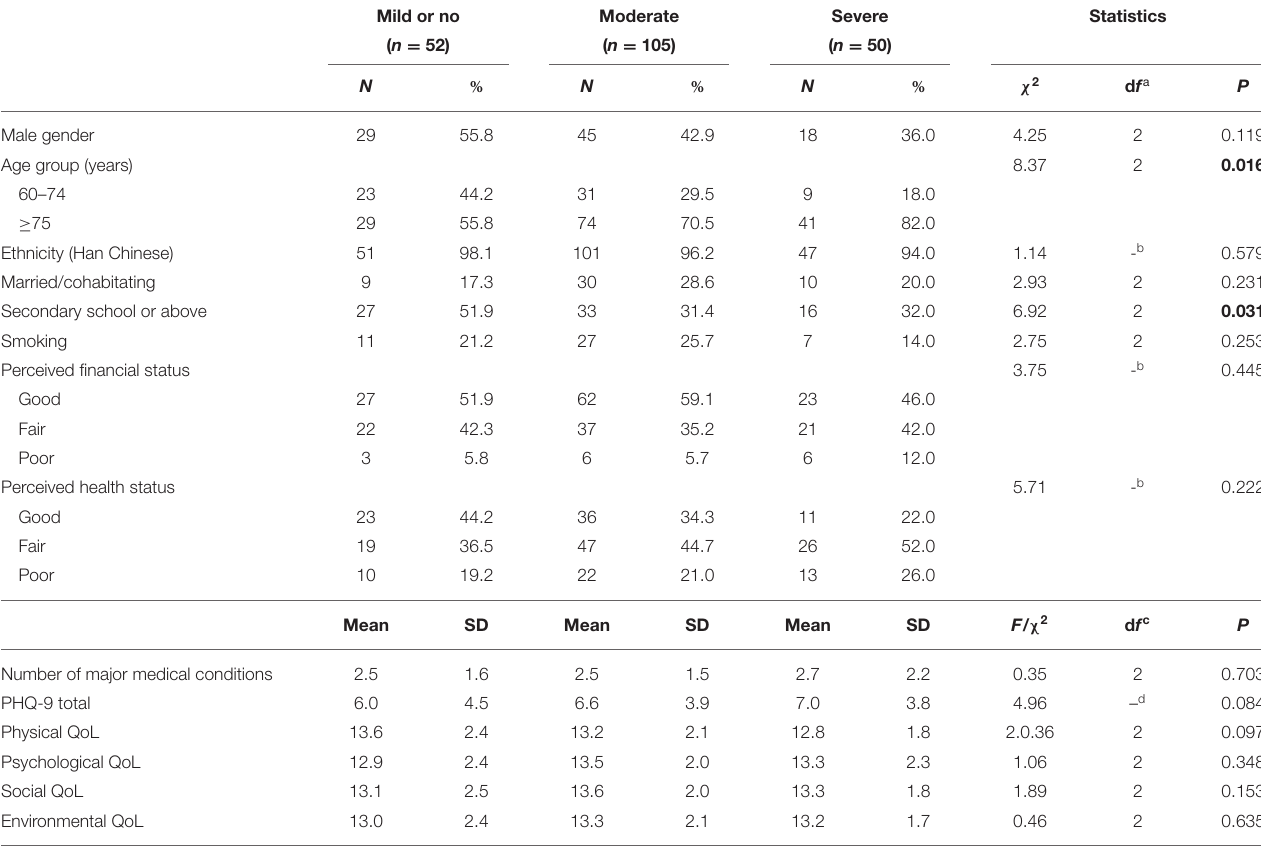
TABLE 2 | Socio-demographics of older adults with cognitive impairment living in high altitude area. Mild or no Moderate